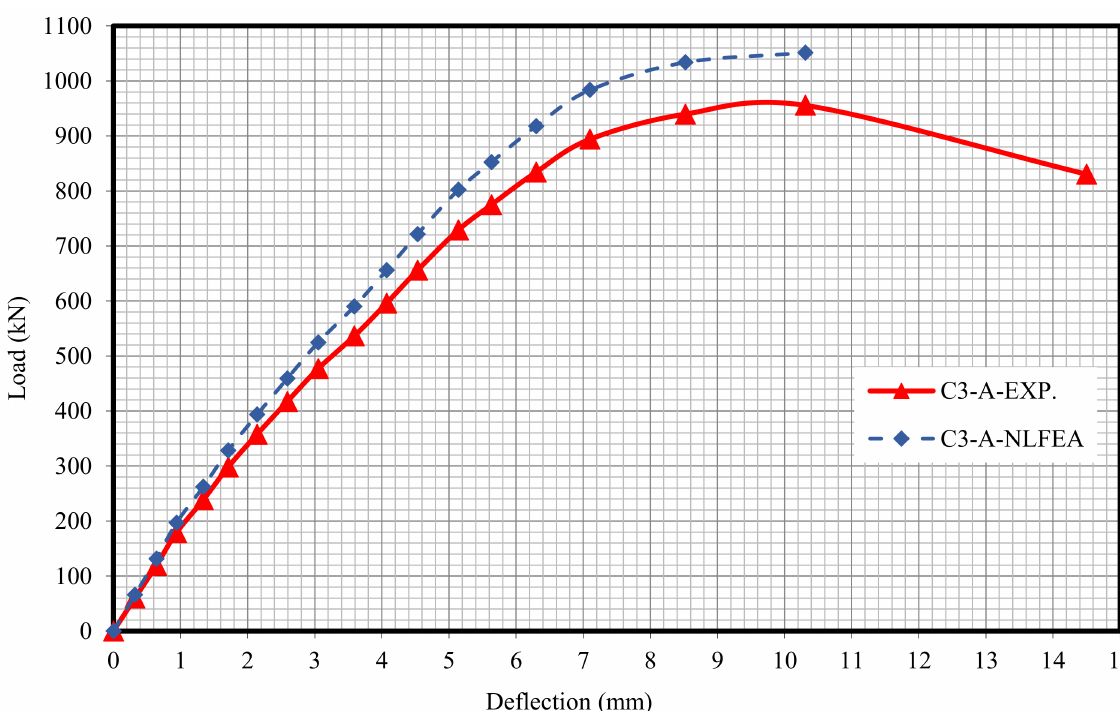
Figure 24. Load deflection of Column